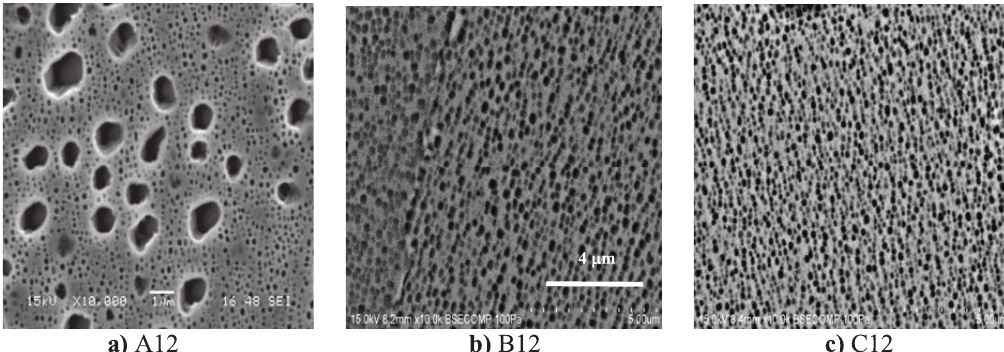
Figure 17. Microstructures of specimens after reheat treatment of Program 2. 3.5 Microstructures of A21-B21-C21 and